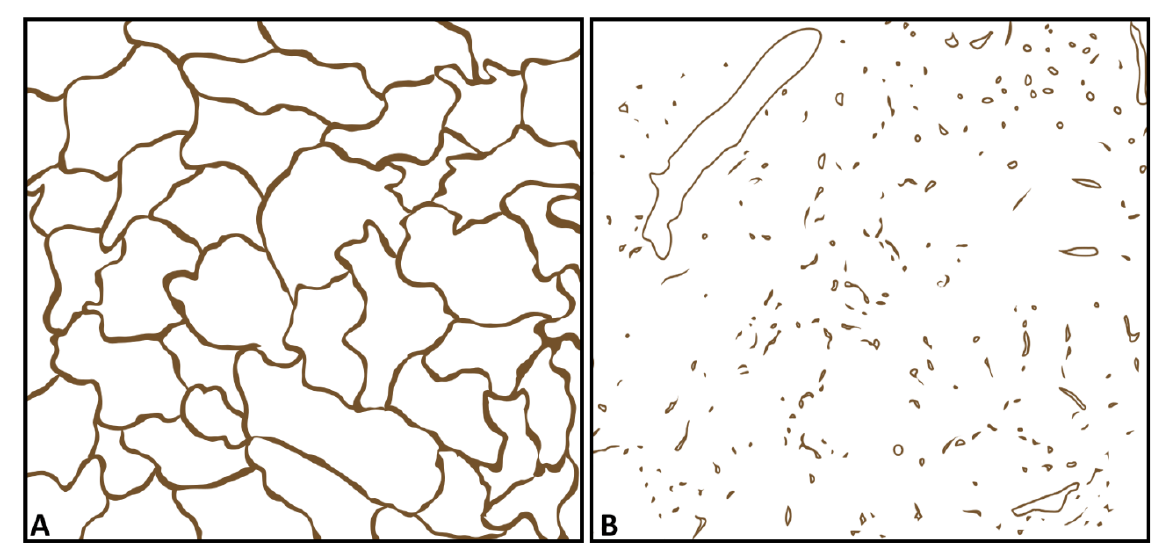
Figure 1. Graphical representation of patterns of immunohistochemistry for CD34 as a marker of endothelial cells [31]. ( A ) A regular alveolar pattern corresponding to the pulmonary capillary vascular pattern in healthy lung tissue [17] or acute pneumonia [17], as the corresponding pattern for pulmonary arterial supply. ( B ) A disorganized and chaotic vascular pattern similar to bronchial arterial neoangiogenesis in malignant lung tumors, as the corresponding pattern for bronchial arterial supply [17].